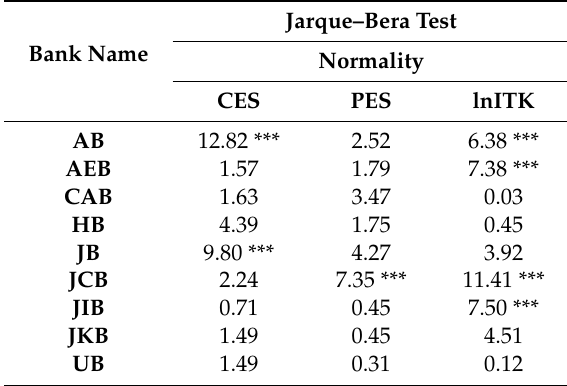
Table A1. Diagnostic for normality using the Jarque-Bera